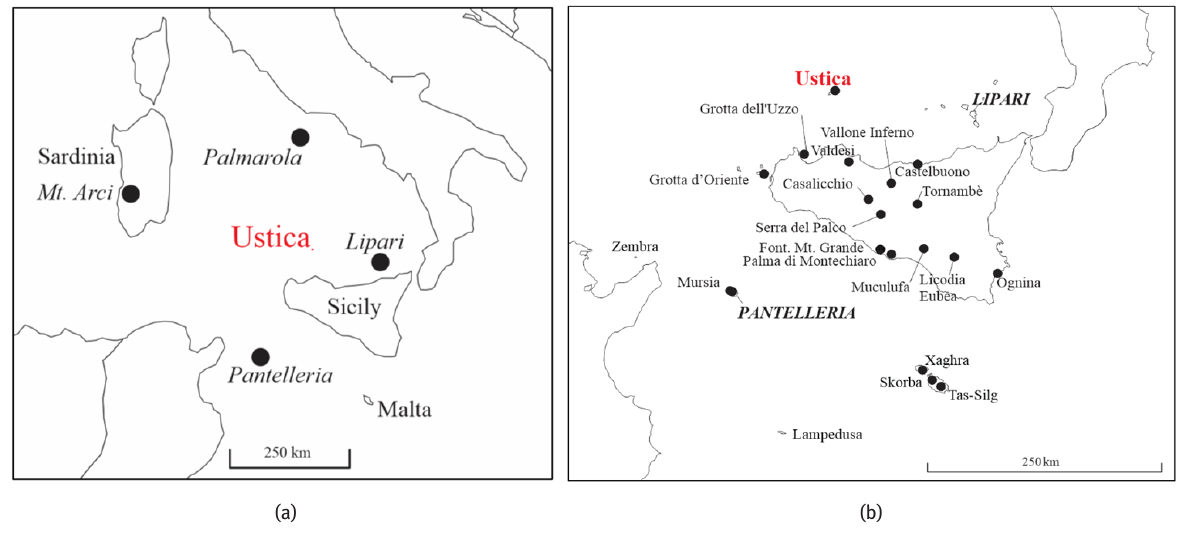
Figure 1: A) Map of obsidian sources and islands in the central Mediterranean. B) Archaeological sites in Sicily, Malta & Tunisia with ≥ 25 artifact analyses and at least some Pantelleria